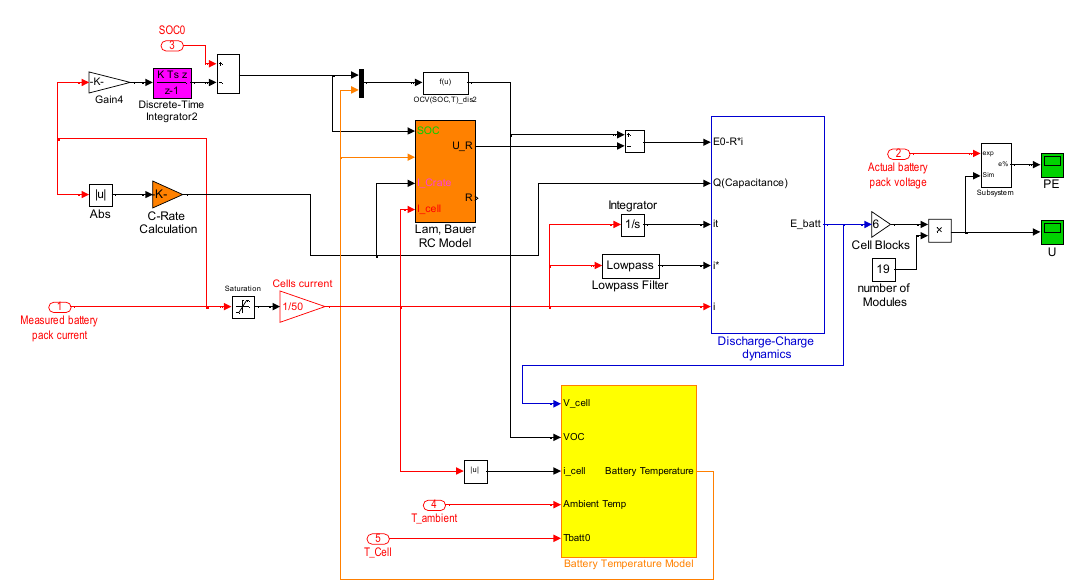
Figure 12. The proposed synthesized battery model and reference voltage signal: ( a ) Proposed model response for the circular driving test; ( b ) Error of proposed model voltage for the circular driving test; ( c ) Proposed model response for the rapid acceleration and deceleration driving test; ( d ) Error of proposed model voltage for the rapid acceleration and deceleration driving test.